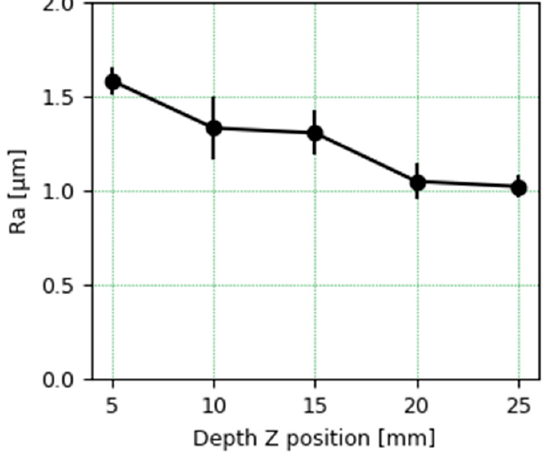
Figure 14. Average roughness (Ra) at di ff erent Z tool positions from 5 mm to 25 mm.